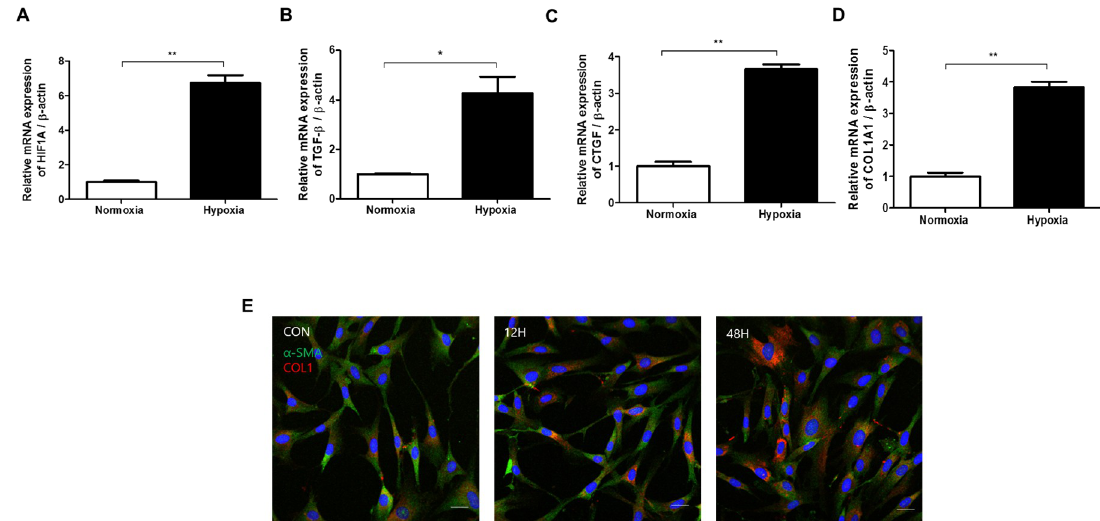
Figure 2. E ff ect of hypoxia on transcription factor-beta (TGF- β ) signaling and epithelial–mesenchymal transition (EMT) marker expression in HDFs. Quantitative reverse transcription polymerase chain reaction (qRT-PCR) analyses of ( A ) HIF-1 α , ( B ) TGF- β 1, ( C ) connective tissue growth factor (CTGF), and ( D ) type I collagen mRNA 48 h after hypoxia exposure, as compared to a normoxia control group. 12, and 48 h after hypoxia exposure; DAPI (blue), α -SMA (green), type I collagen (red). Results